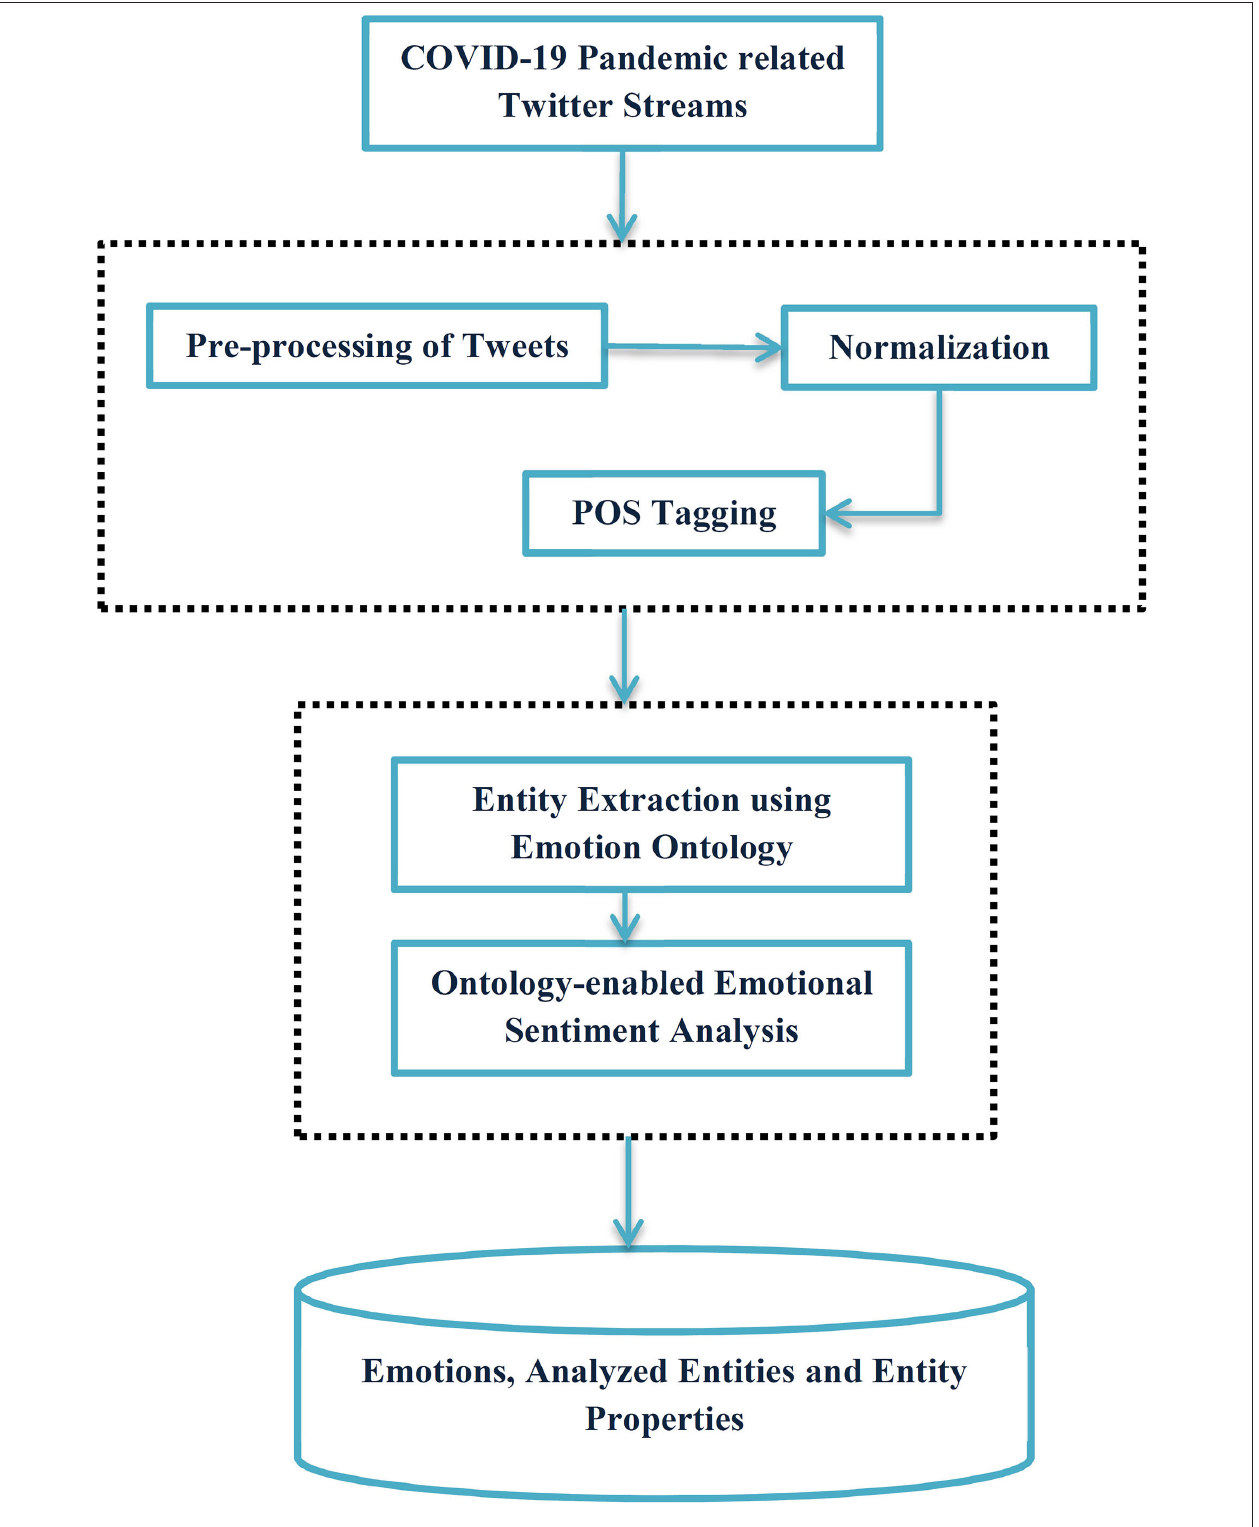
FIGURE 1 | Proposed architecture for emotion extraction from